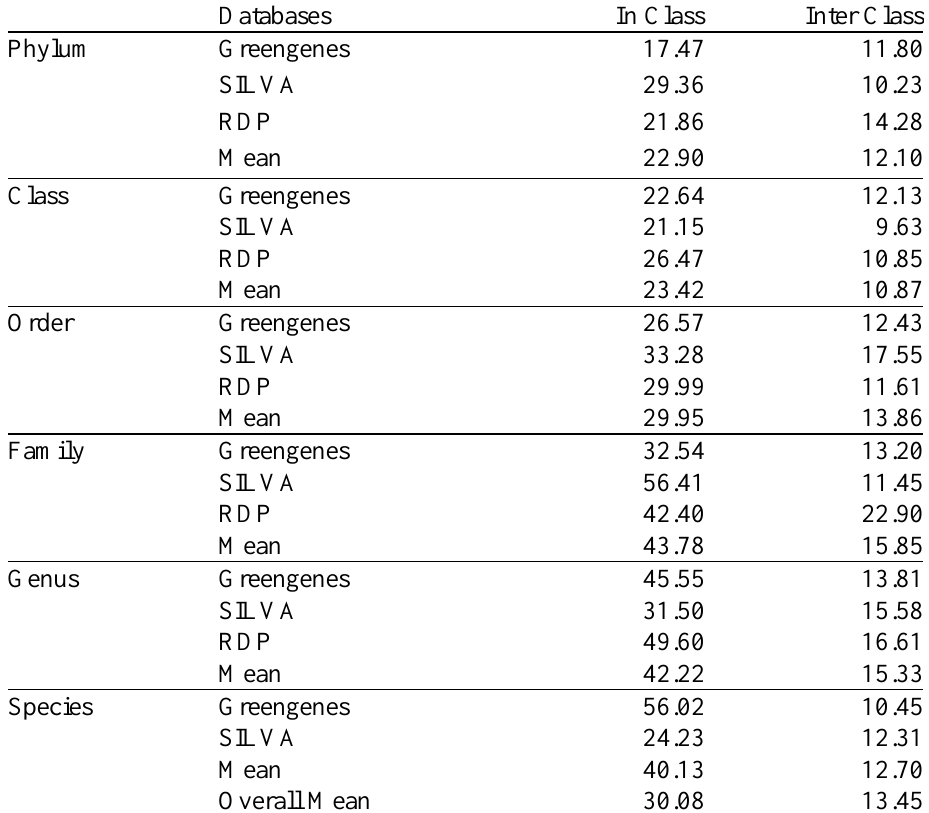
Table 1. similarities in class/ Inter Class for family level